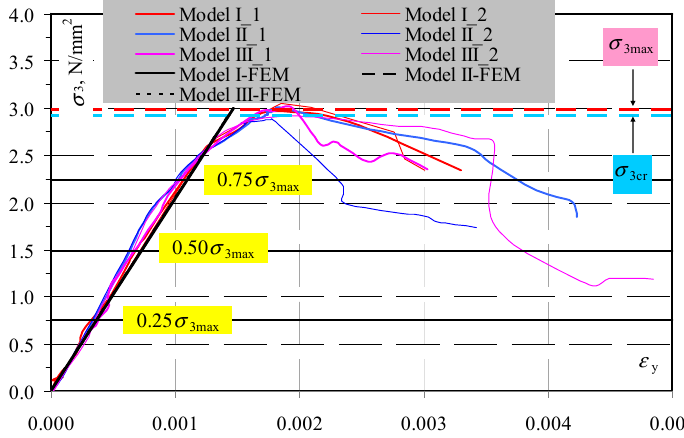
Figure 19. Compared relationships between stress and strain ( σ 3 – ε y ) for all tested models and numerical FEM models.